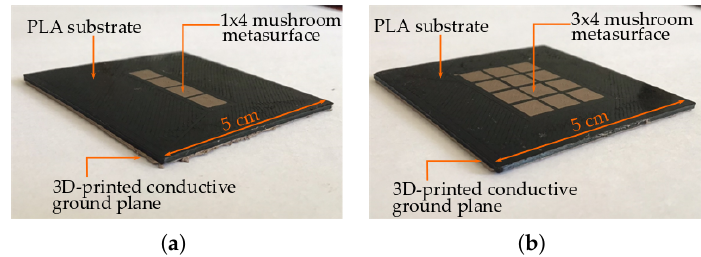
Figure 14. 3D-printed metasurfaces. ( a ) 1 × 4 mushroom with printed conductive ground plane. ( b ) 3 × 4 mu shroom with printed conductive ground